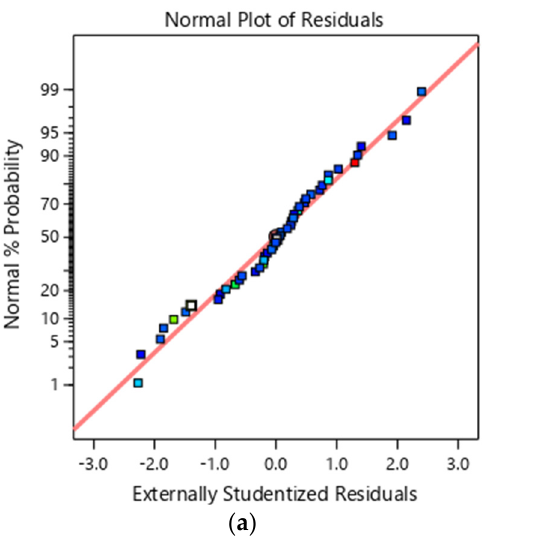
Figure 4. ( a ) Normal probability plot of the externally studentised residuals for the T-funnel fitted model, and ( b ) plot of the externally studentised residuals versus T-funnel fitted values. Table 8. T-funnel model coefficients (coded values).